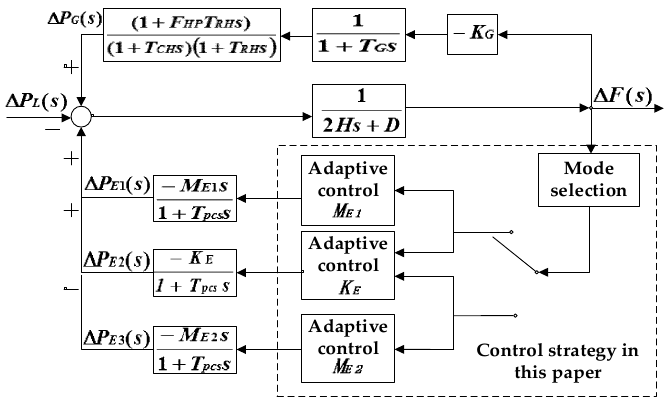
Figure 1. Frequency regulation dynamic model.